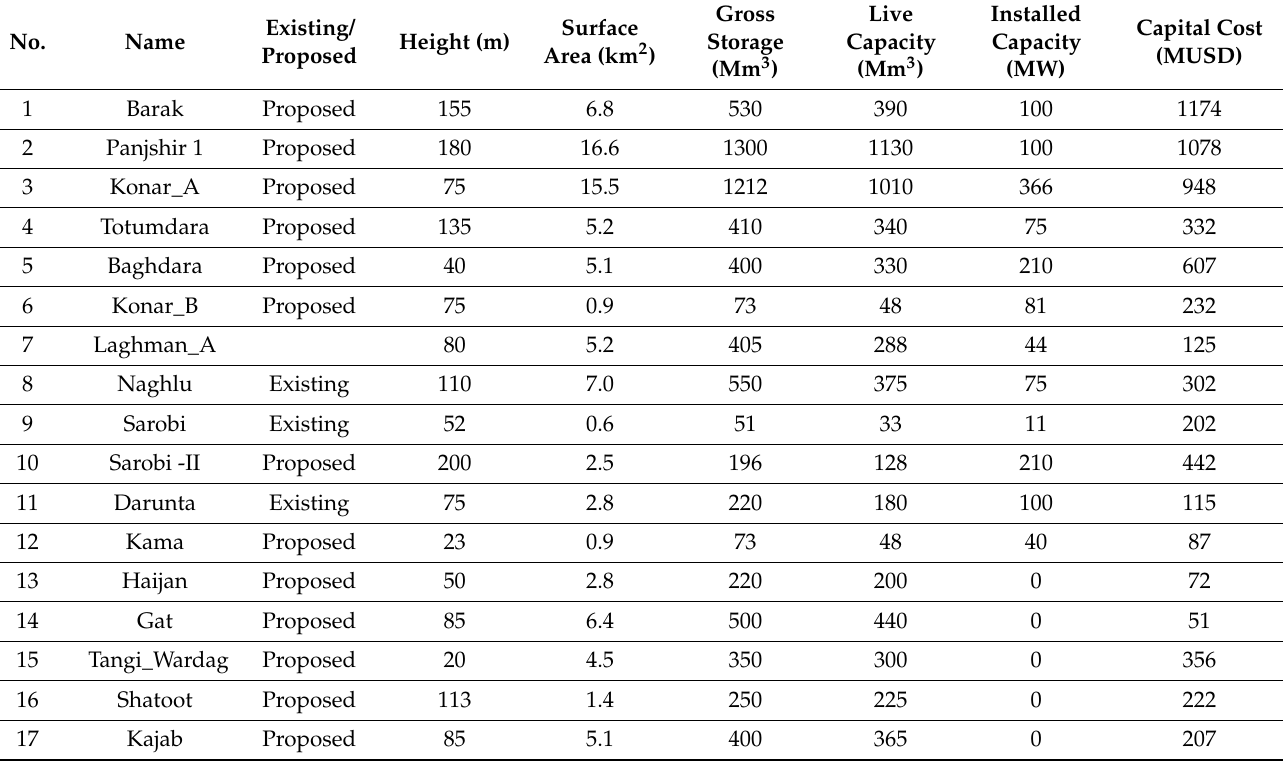
Table 1. Existing and proposed dams in the KRB (Afghanistan) (Source: WB, 2010; Vol 1, Chapter 4, Toosab and RCUWM 2006 mission